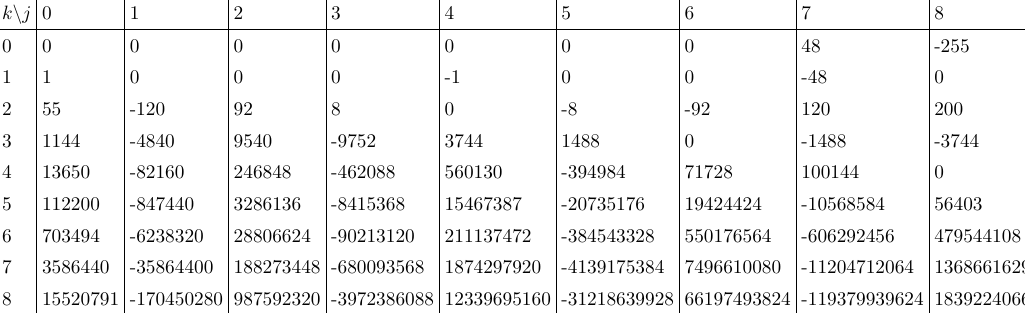
Table 68. Table of b jk coe(cid:14)cients for h SO(11)